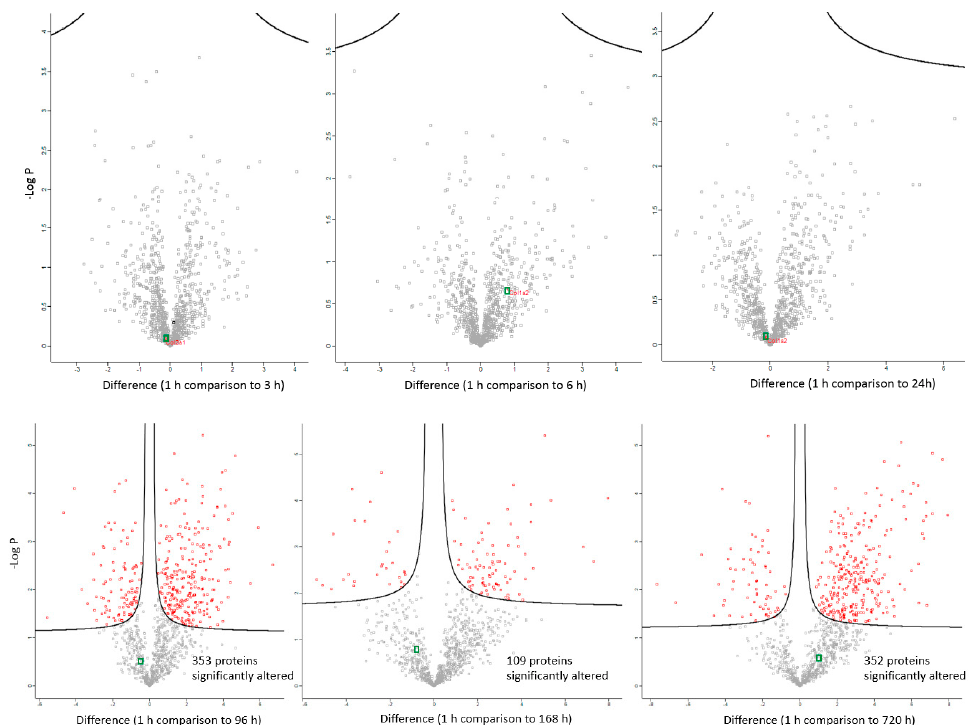
Figure 1. Differentially abundant proteins across PM (post mortem) time scales. Significantly differential proteins are demarcated by red points. Collagen is demarcated by green points. Significantly altered abundances occur after 24 h post mortem compared to the 1 h time point with up to 352 proteins changing in their abundance 1 month after death (720 h).